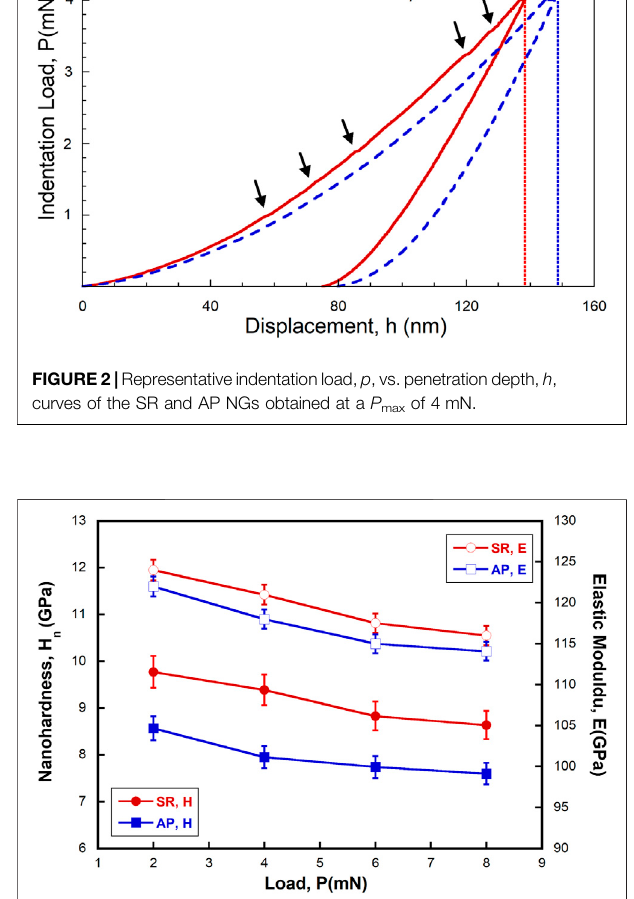
FIGURE 3 | Variation of nanohardness, H n , and elastic modulus, E , with maximum indentation load, P max , of both SR and AP NGs indicating the ISE.